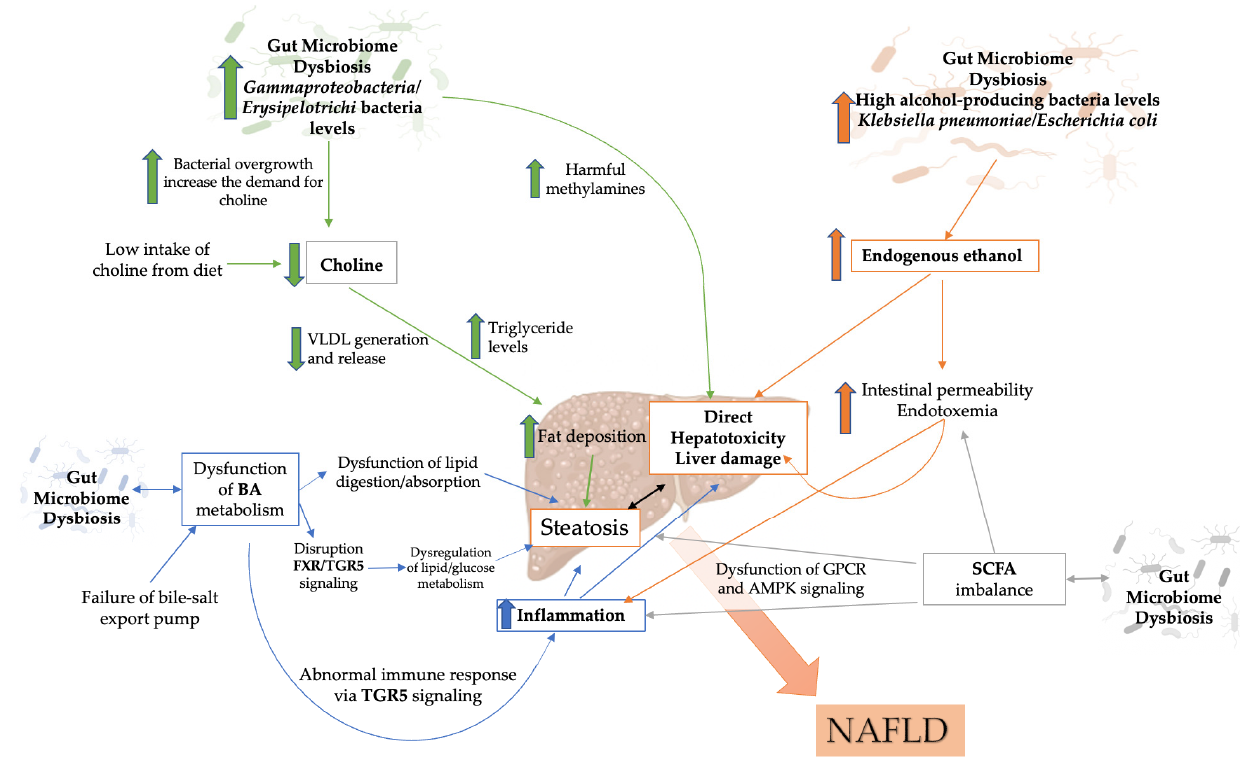
Figure 3. Schematic illustration of metabolites produced from the dysbiotic gut microbiome and involved in NAFLD pathogenesis. Created with https://BioRender.com (accessed on 29 October 2022) and modified with Microsoft PowerPoint v.16. BA: bile acid; SCFA: short-chain fatty acid; NAFLD: non-alcoholic fatty liver disease; FXR: Farnesoid Receptor X; TG5R: G-Protein-Coupled Bile Acid Receptor Gpbar1; GPCR: G-protein-coupled receptors; AMPK: AMP-activated protein kinase; VLDL: Very Low-Density Lipoprotein.